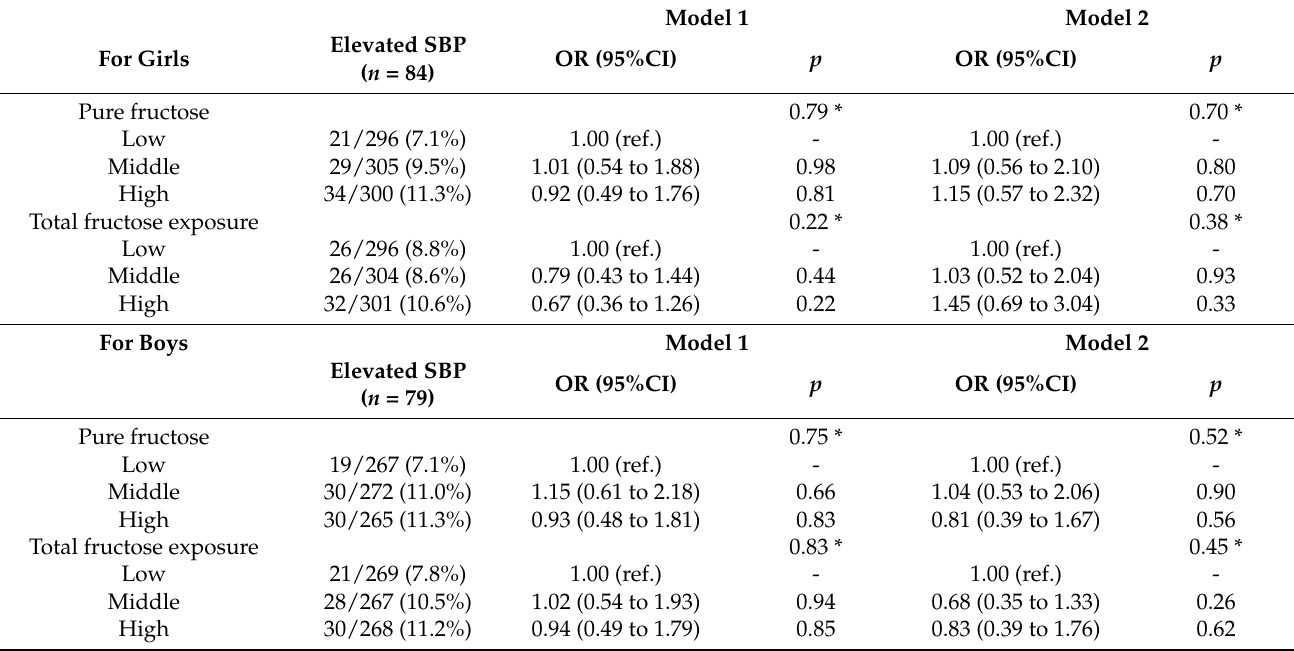
Table 6. Association between elevated systolic blood pressure with pure and total fructose exposure from non-natural foods.